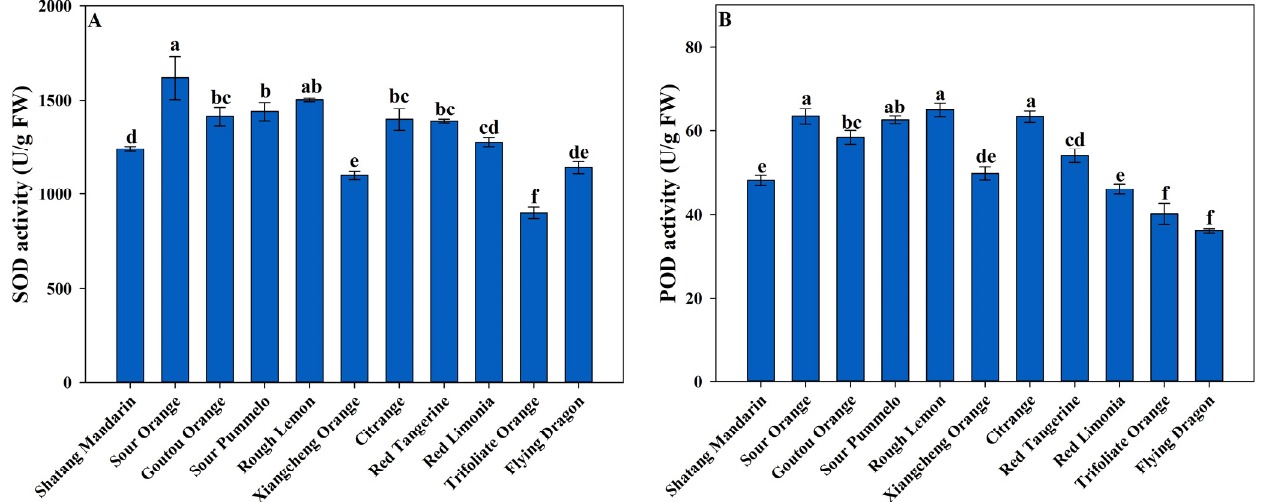
Figure 2. Enzymatic antioxidant activities in leaf tissues of ‘Shatangju’ scion cultivar grafted onto different rootstocks. SOD ( A ), POD ( B ). Error bars indicate the standard error of three biological replicates, and lowercase letters indicate significant differences between rootstocks by LSD ( p ≤ 0.05).